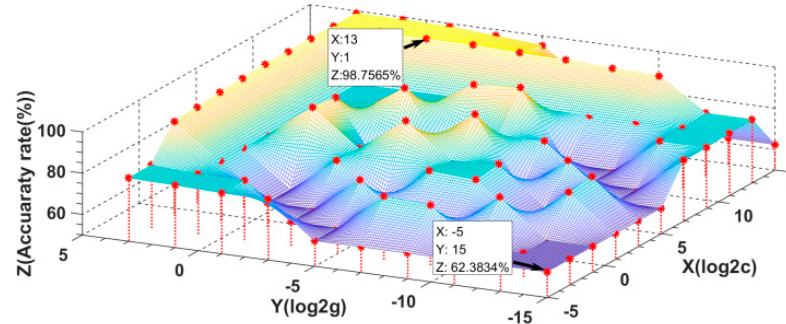
Figure 16. Cross-validation results for the model parameters.